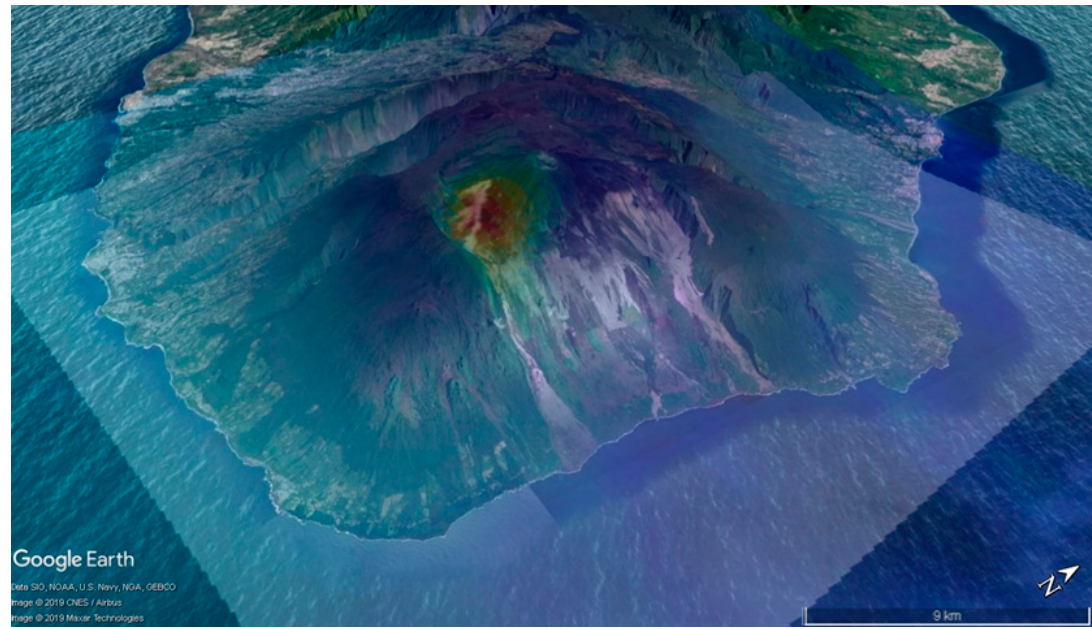
Figure 6. Piton de la Fournaise volcano, Réunion Island (summit location: 21.24°S, 55.71°E) during the April–May 2018 eruption crisis. Image / data modified from Harris et al. [44]. A color-coded Moderate Resolution Imaging Spectroradiometer (MODIS) radiance image produced by the Middle InfraRed Observation of Volcanic Activity (MIROVA) monitoring system is draped over a 3D Google Earth visible image for context. These KML image products are routinely produced by MIROVA. Draped on both data sets is the nighttime ASTER TIR data acquired as part of the URP Program. The ASTER image, acquired 6 days after the triggering MODIS detection, shows the spatial details of the propagating lava flow as the brighter white pixels within the colorized MODIS pixels.